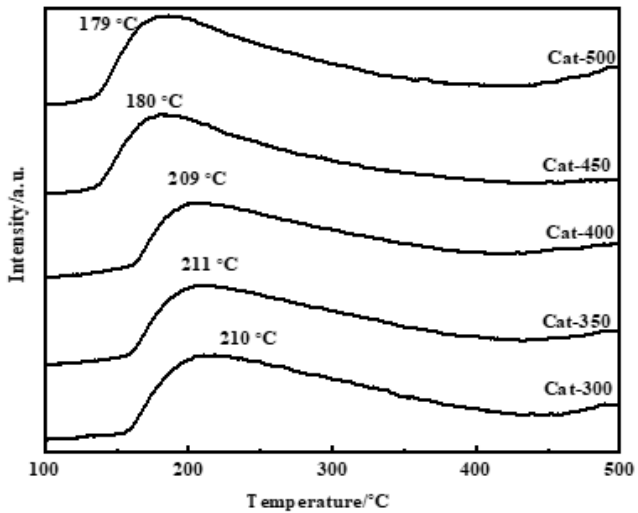
Figure 4. NH 3 -TPD profiles of different Ni 2 P/Al 2 O 3 catalysts.